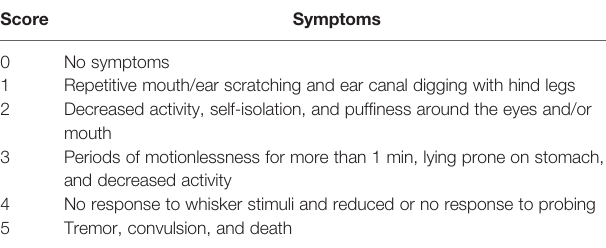
TABLE 1 | Clinical anaphylaxis symptom scoring system of